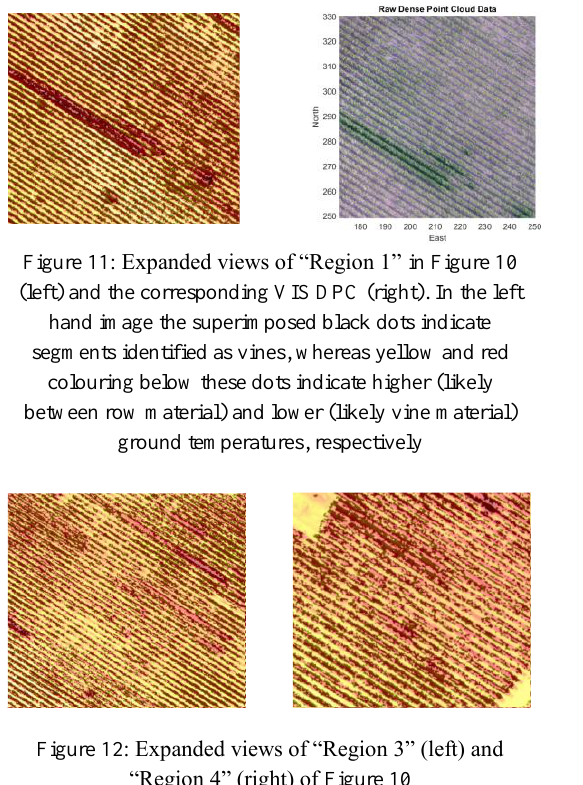
Figure 12: Expanded views of “Region 3” (left) and “Region 4” (right) of Figure 10 Closer inspection of an expanded region (Figure 11)